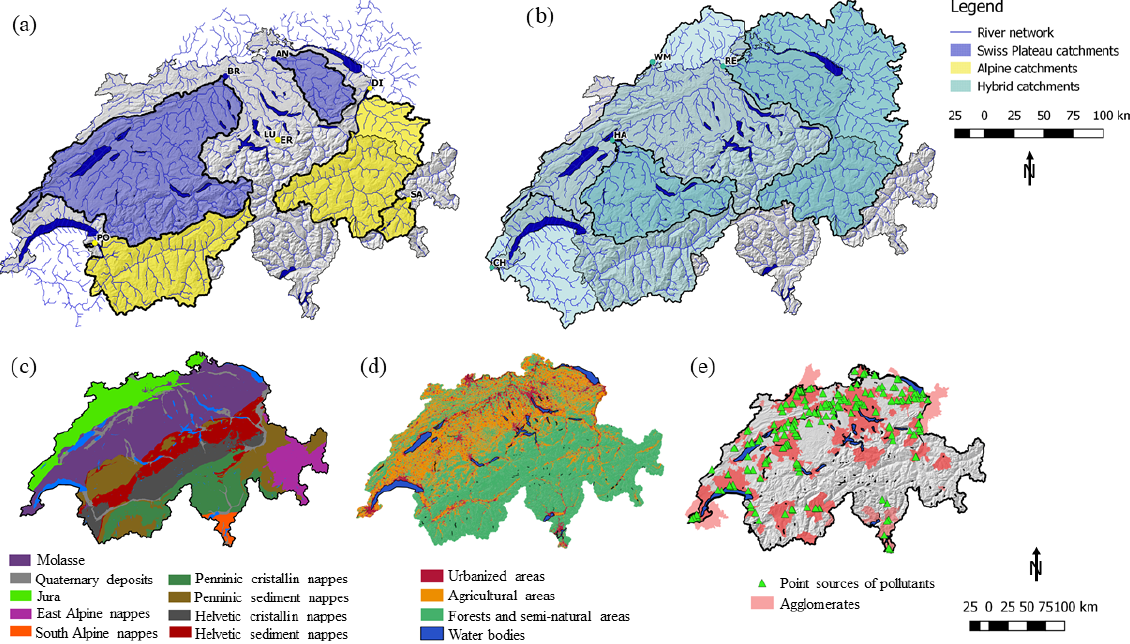
Figure 1. Map of NADUF monitoring stations and description of the study area. The upper panel represents the studied catchments. (a) Swiss Plateau (blue) and the Alpine catchments (yellow); (b) the catchments spanning both regions, hybrid catchments (light blue). The bottom panel describes the study sites in terms of (c) macro-geological classes, (d) land cover, and (e) anthropic